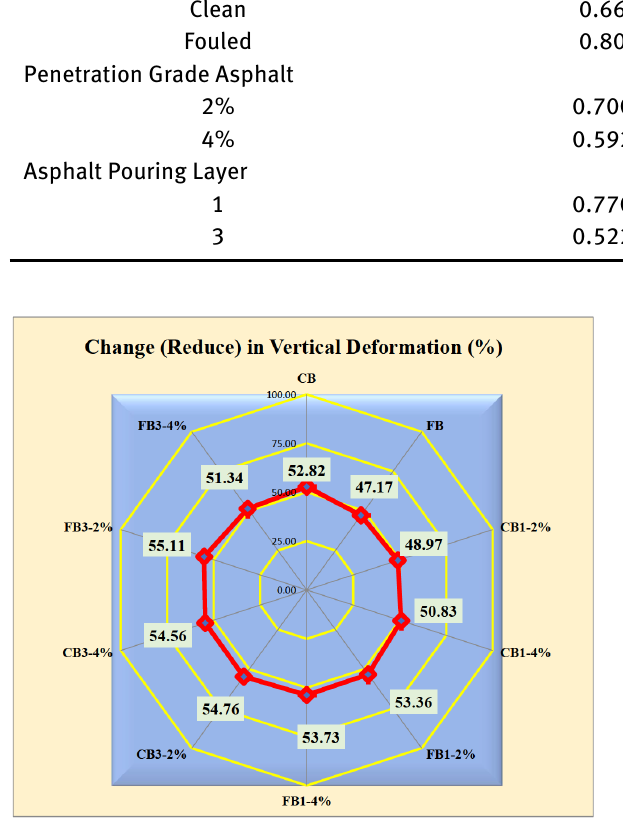
Figure 7: Vertical deformation rate change (percentage)